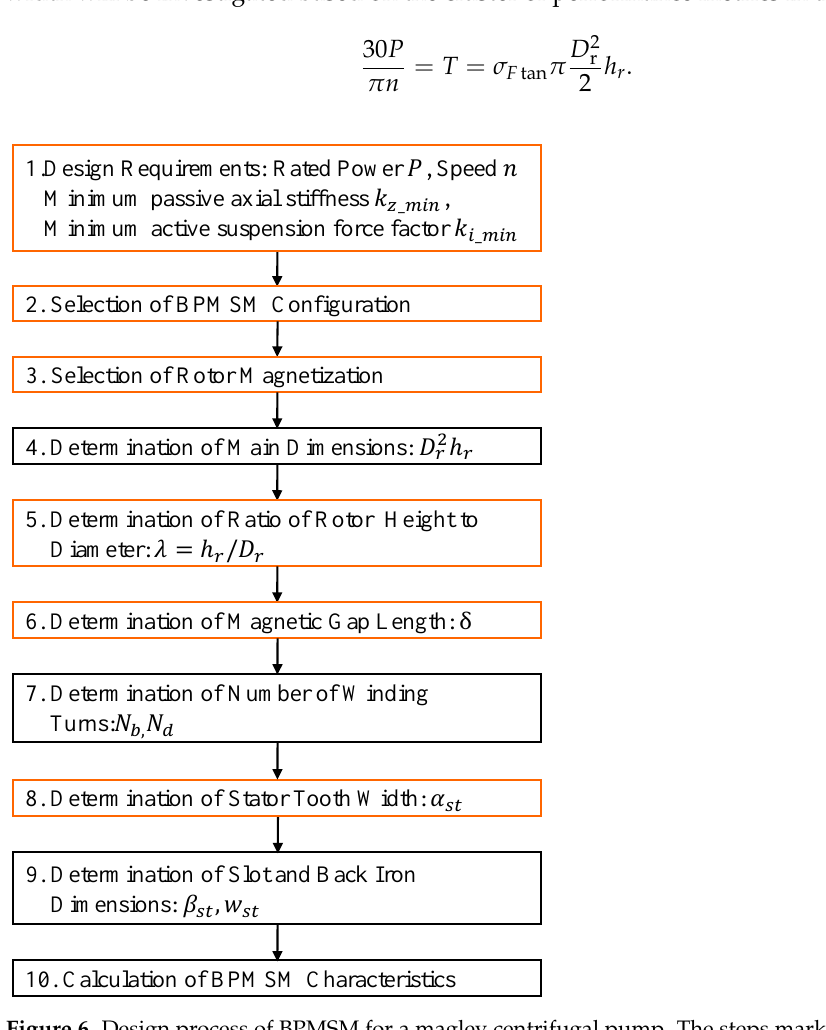
Figure 6. Design process of BPMSM for a maglev centrifugal pump. The steps marked orange adopt the proposed method based on the cluster of performance metrics, and the remaining ones are based on the design procedure for normal AC motors